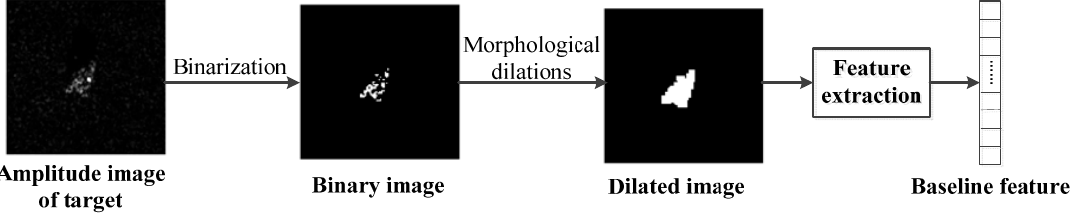
Figure 2. Framework of feature extraction. Table 1. The selected baseline features.